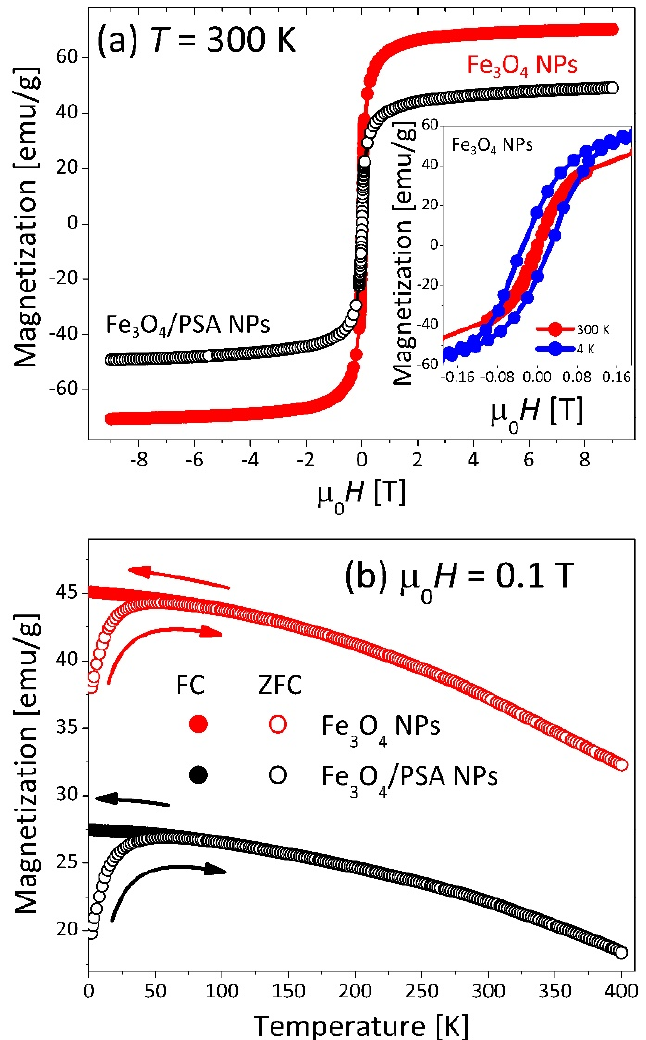
Figure 4. Magnetic properties of studied materials. ( a ) Magnetic field variation of the magnetization M ( µ 0 H ) in studied materials measured at room temperature. The inset shows a zoom-in to the low field region for magnetization curves collected at room temperature and 4 K for Fe 3 O 4 NPs. ( b ) Temperature dependencies of the magnetization M ( T ) for prepared samples measured in a magnetic field of 0.1 T upon cooling the sample in zero-field (ZFC) and applied field (FC). Magnetization curves, M ( µ 0 H ), collected at room temperatures ( T = 300 K)